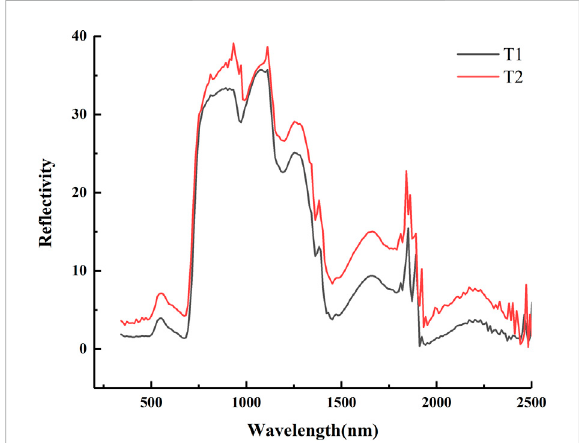
FIGURE 6 The spectral curves of S. vulgaris represent the law of “ fi ve grains andfourpeaks. ” Thereissomedifferenceinre fl ectance,but the difference is not signi fi